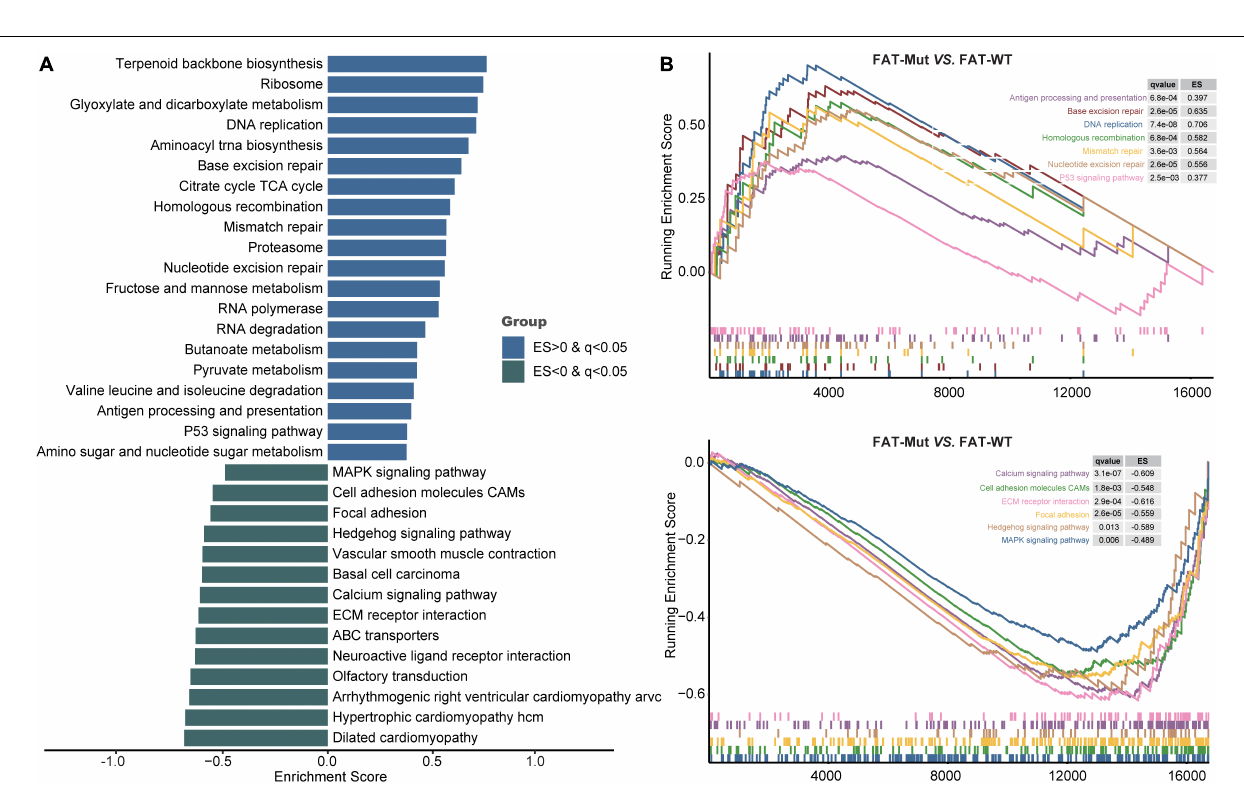
Frontiers in Medicine |